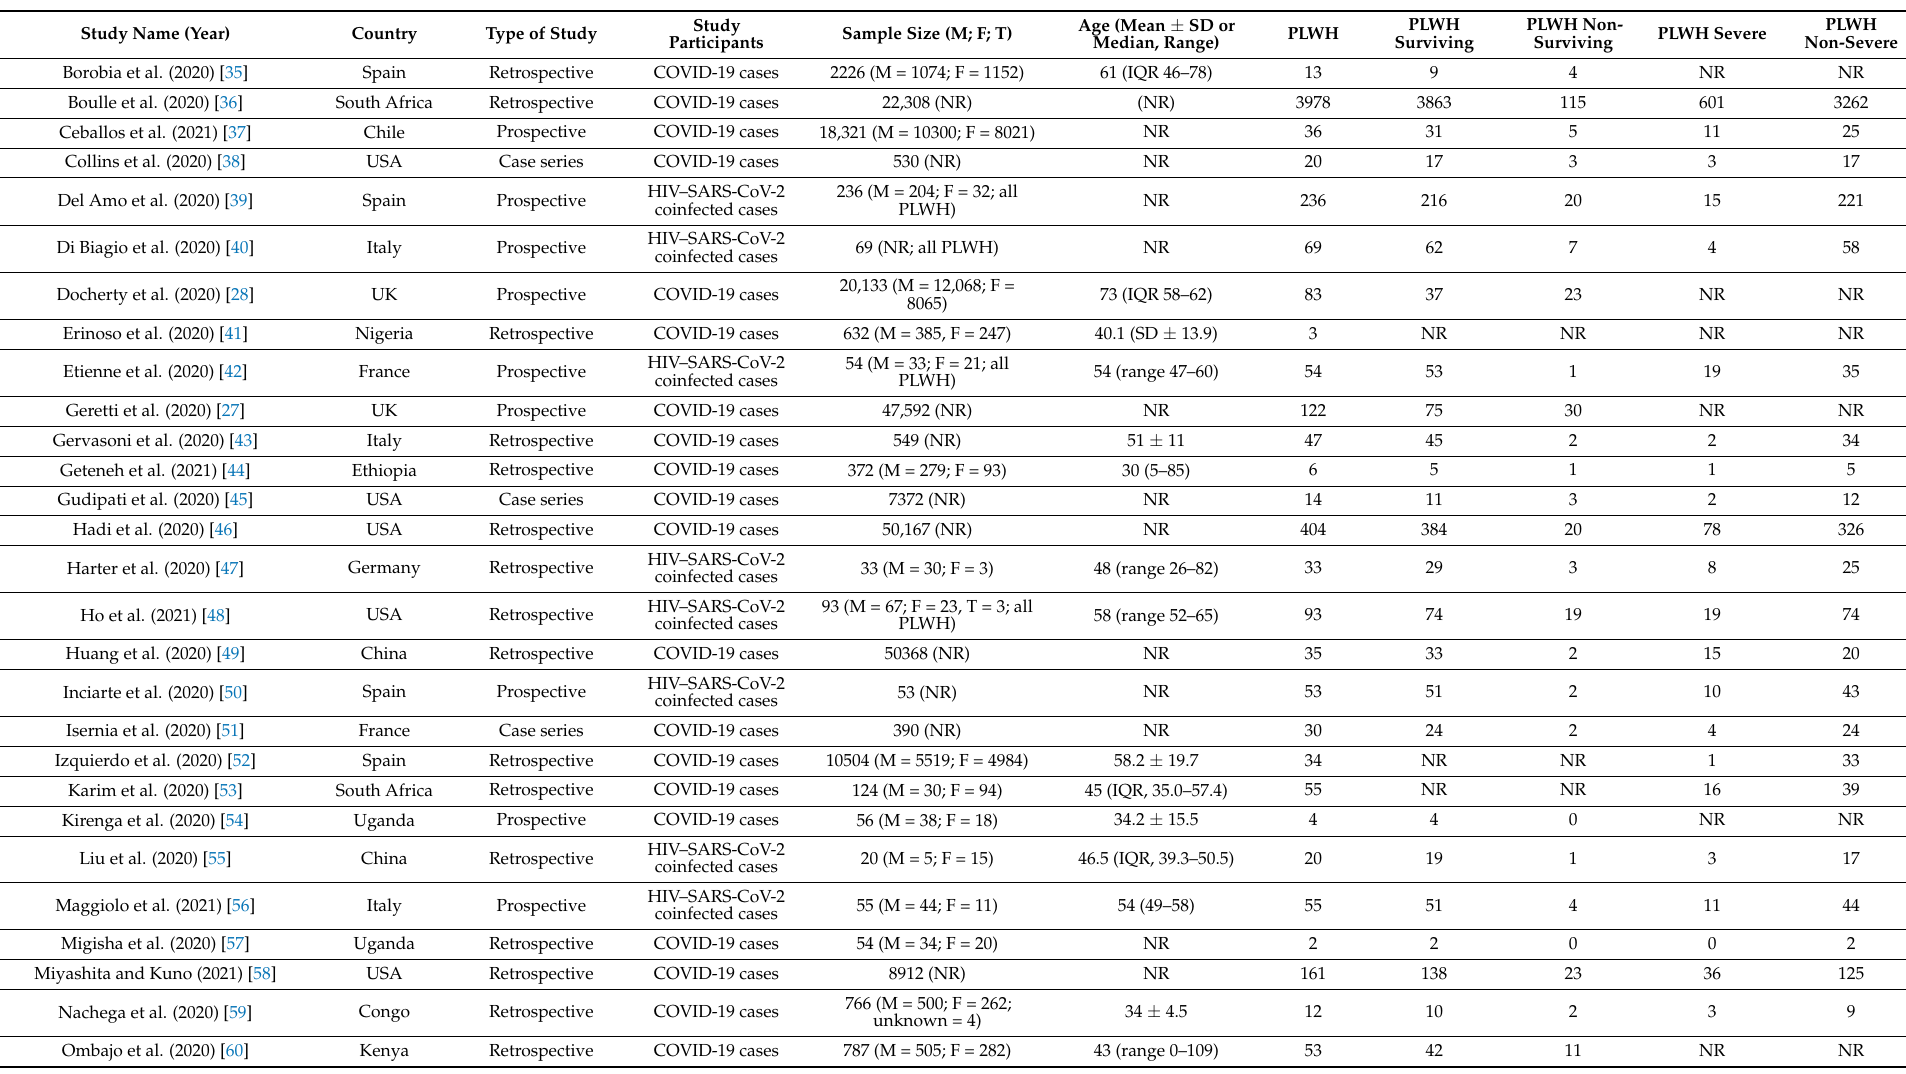
Table 1. General characteristics of included